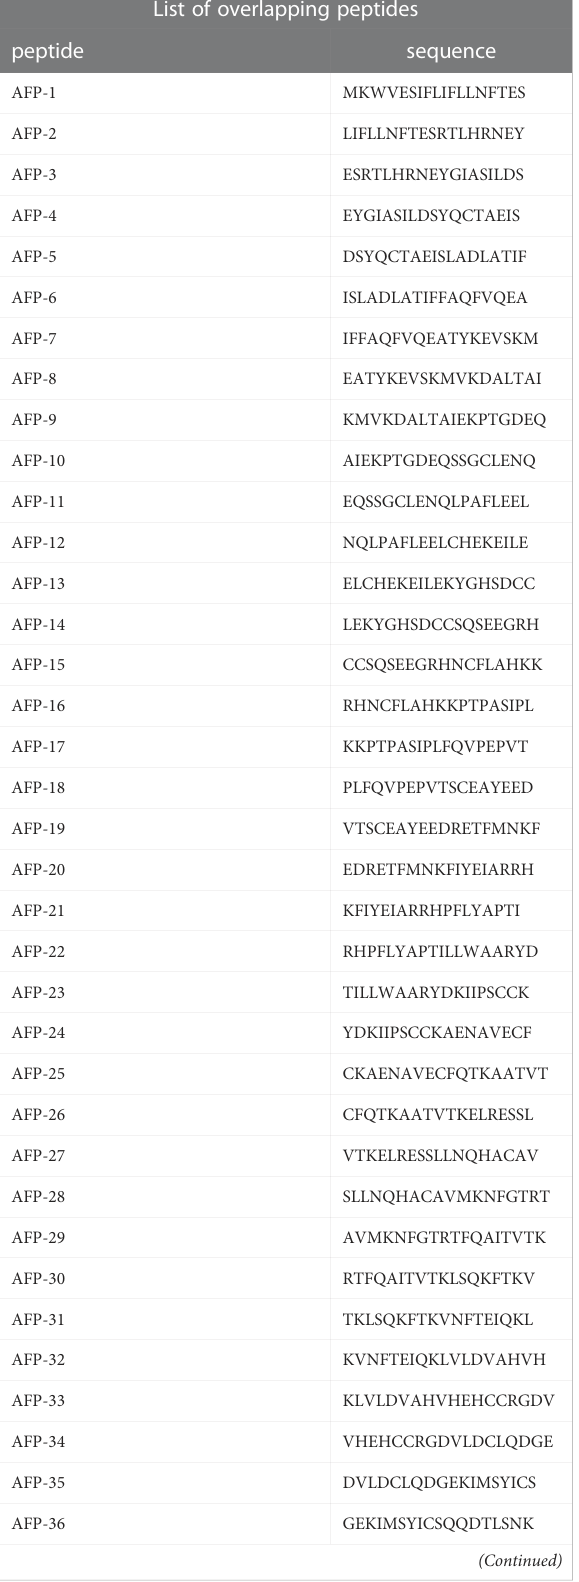
TABLE 1 The sequences of the overlapping peptides for each of the six antigens and their position within the protein sequence are shown. List of overlapping